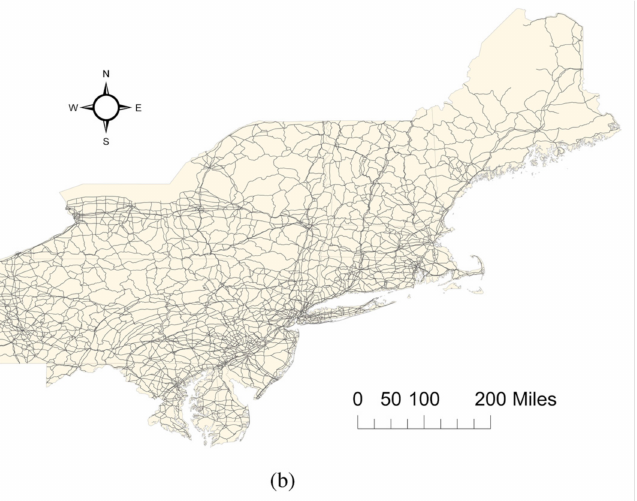
Figure 6. Small-scale map for northeastern United States of America road network: ( a ) 1:1,000,000 and ( b )